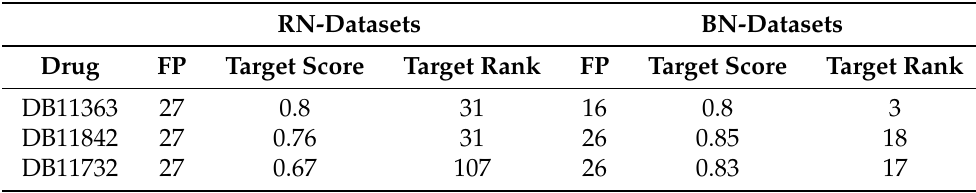
Table 3. DTI prediction results for 3 marketed drugs, when the algorithm is trained on the RN- datasets or the BN-datasets: number of False Positive predicted targets, score and rank of the true